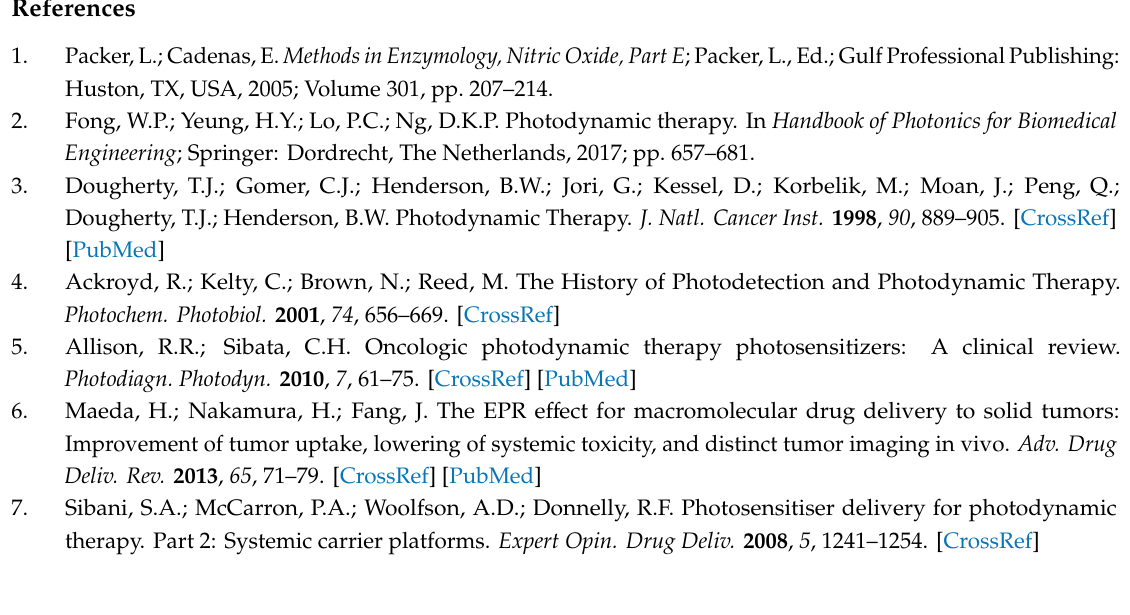
Figure S1: VEGFR2 expression in the murine cell line measured by flow cytometry, Figure S2: Microscopic images of VEGFR2 expression in the murine cell lines, Figure S3: In vitro competition experiment of the NB–PS conjugates tested on purified protein in the presence or absence of 10 × and 100 × excess of VEGF, Figure S4: Comparison of F actin staining in non-treated bEnd.3 cells cultured under static or flow conditions, Figure S5: Association of the VEGFR2 and EGFR targeted nanobodies, separately and in combination, with cells of MS1 / OSC